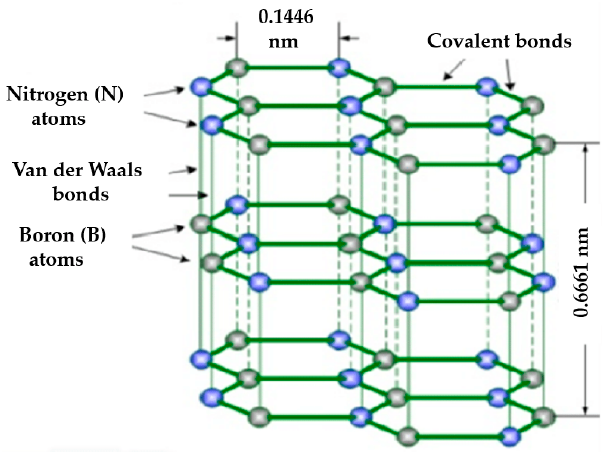
Figure 15. Schematic of hBN structure. (Reprinted with permission from ref. [183]. Copyright 2012 SPIE Publications).